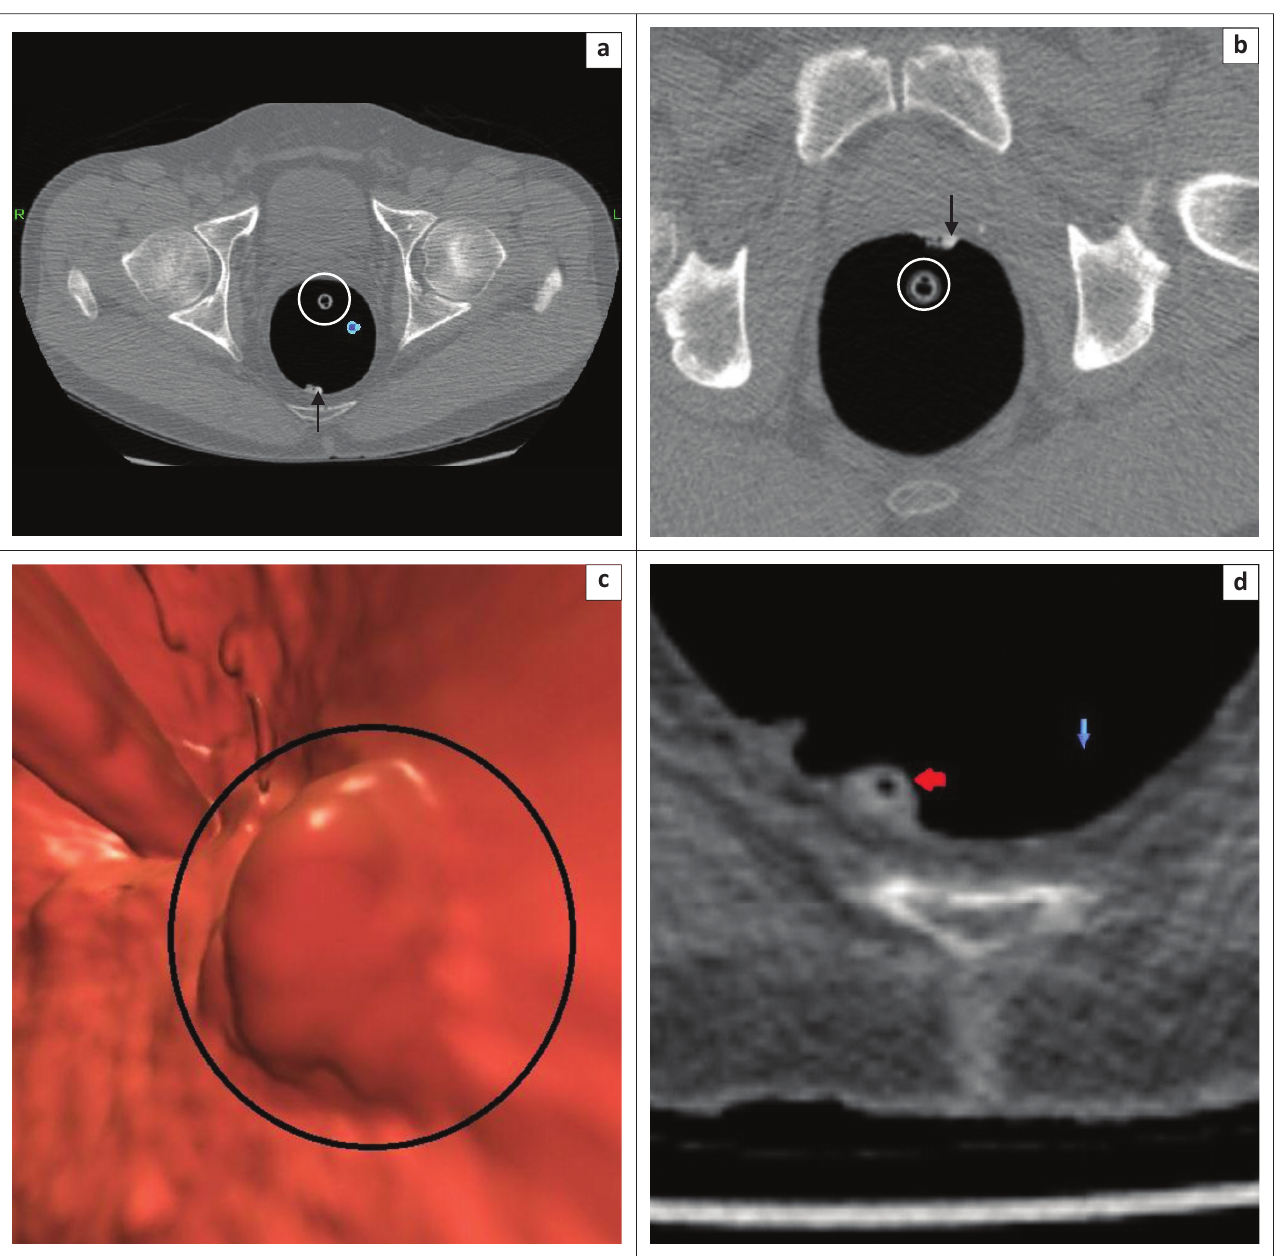
FIGURE 8: (a) 2D supine axial view showing density on posterior wall with lucency within it (black arrow). White circle = rectal catheter; (b) Prone axial study shows the density has shifted to anterior wall indicating stool (black arrow). White circle = rectal catheter; (c) 3D endoluminal view showing polypoidal lesion (black circle); (d) 2D coronal view shows air (red arrow) which indicates the lesion is